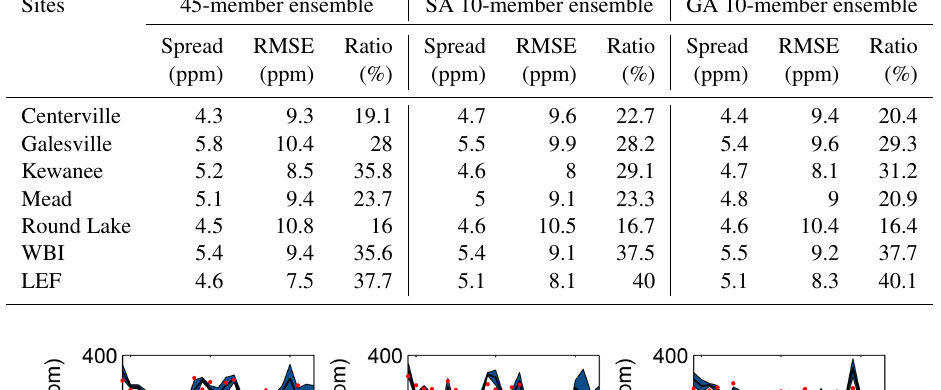
Table 5. Spread (model–ensemble mean), RMSE (model–data) and ratio (spread 2 /RMSE 2 ) at each of the in situ CO 2 mixing ratio towers, for the 45-member ensemble and 10-member ensemble calibrated with SA and GA. Sites